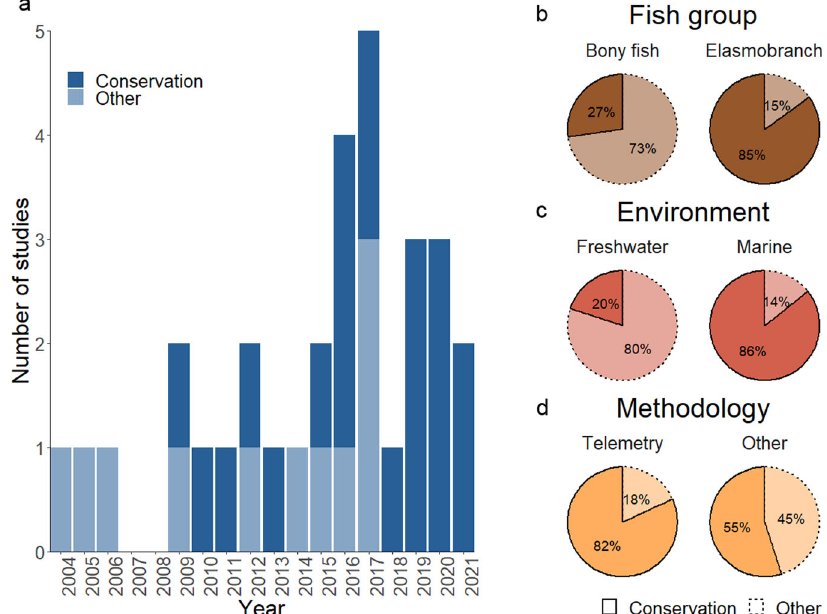
Fig. 2 Wild studies of fi sh social networks. a Several studies have investigated the social networks of fi sh in the wild in the last two decades of which ~68% focused on species of conservation or commercial interest ( “ Conservation ” ). The remainder focused on model species or species of least conservation concern ( “ Other ” ). The percentage of studies related to species of conservation concern varied between b fi sh groups, c environments, and d methodology used. Data for this fi gure were obtained from an extensive search in SCOPUS and by consulting the reference list of the most relevant reviews on the